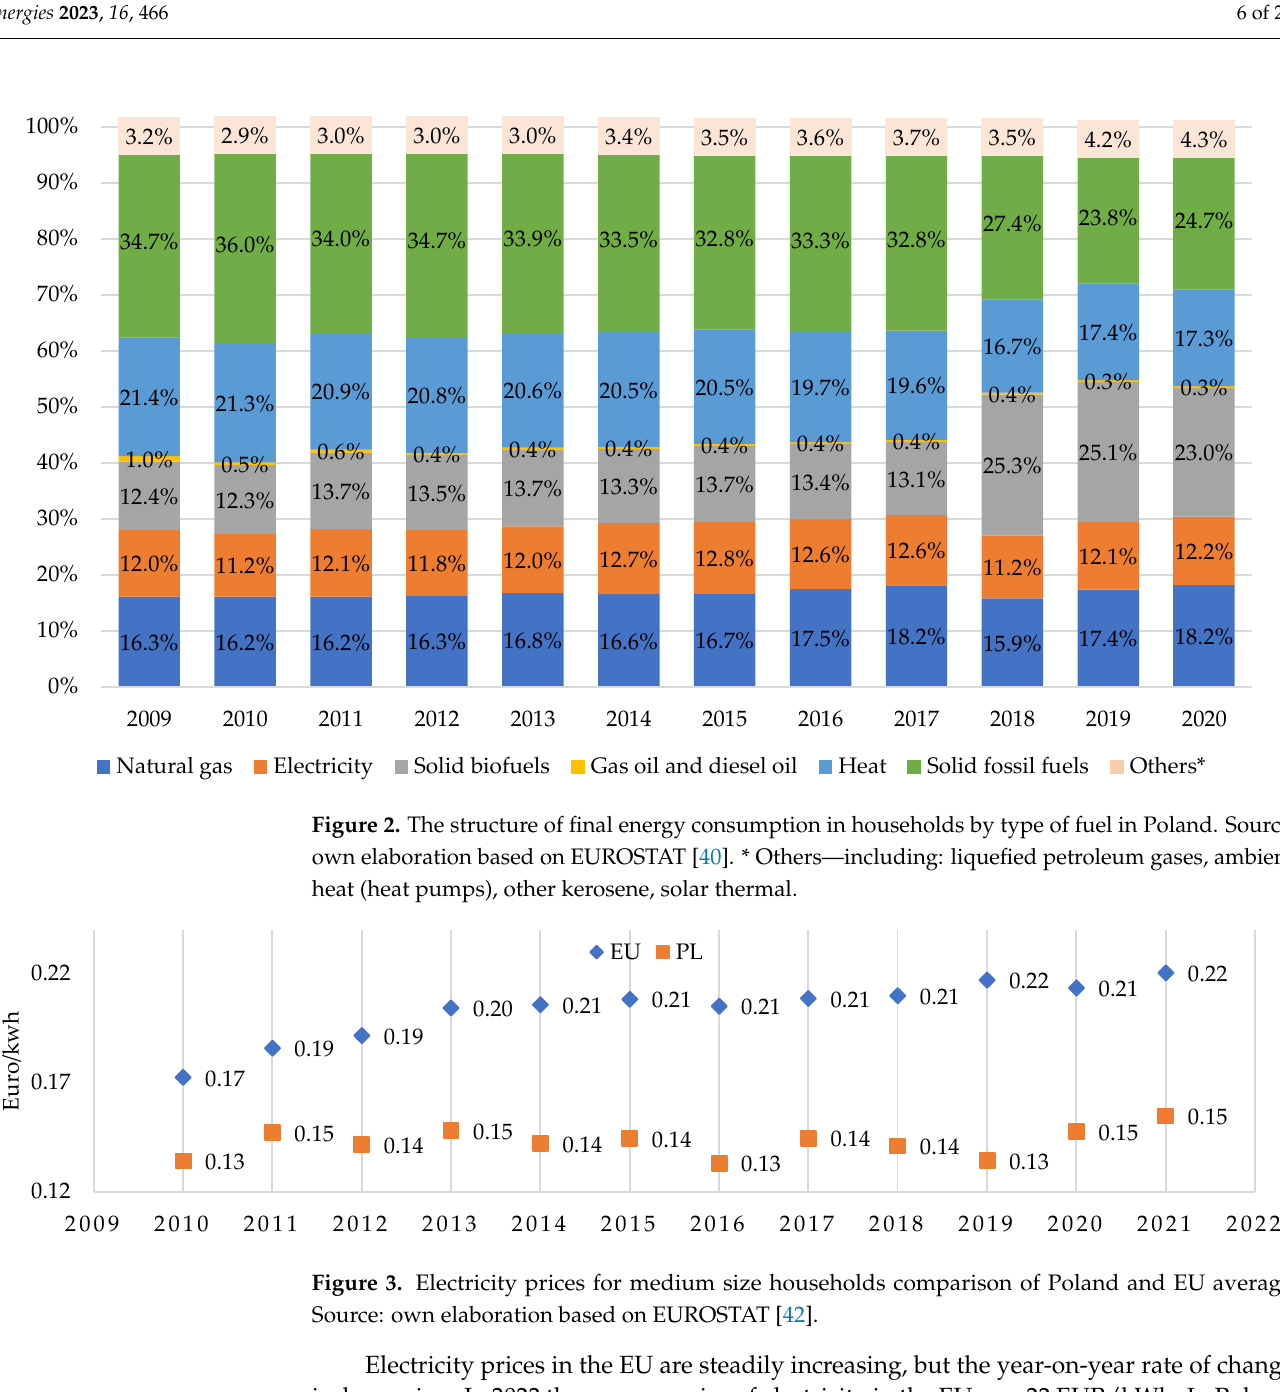
Figure 3. Electricity prices for medium size households comparison of Poland and EU average. Source: own elaboration based on EUROSTAT [42].